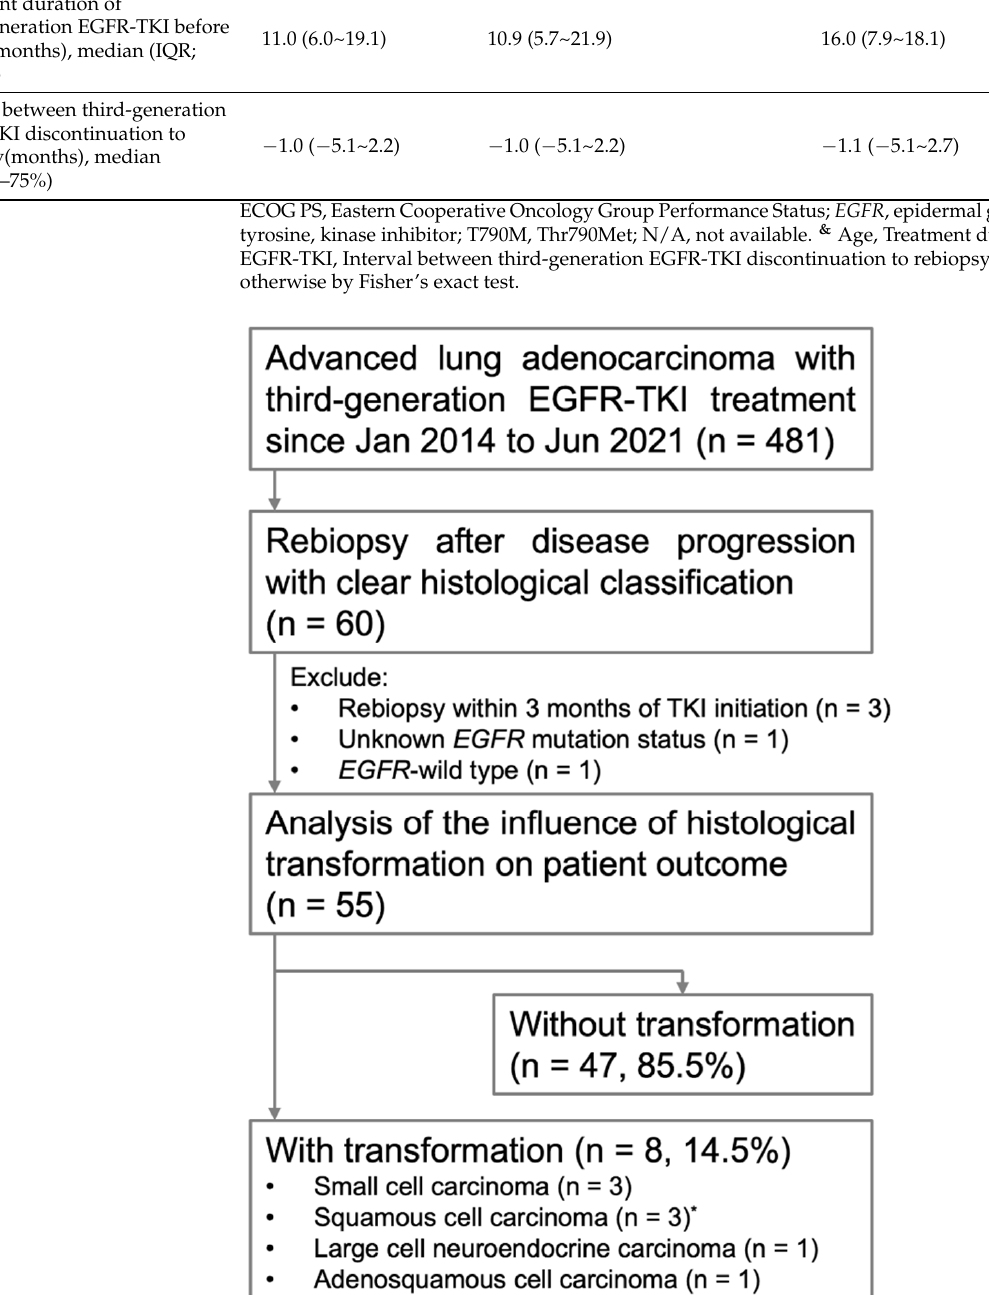
Figure 1. Algorithm for inclusion of study participants. * Includes one patient with transformation into squamous cell carcinoma in the first rebiopsy and into sarcomatoid carcinoma in the second rebiopsy.